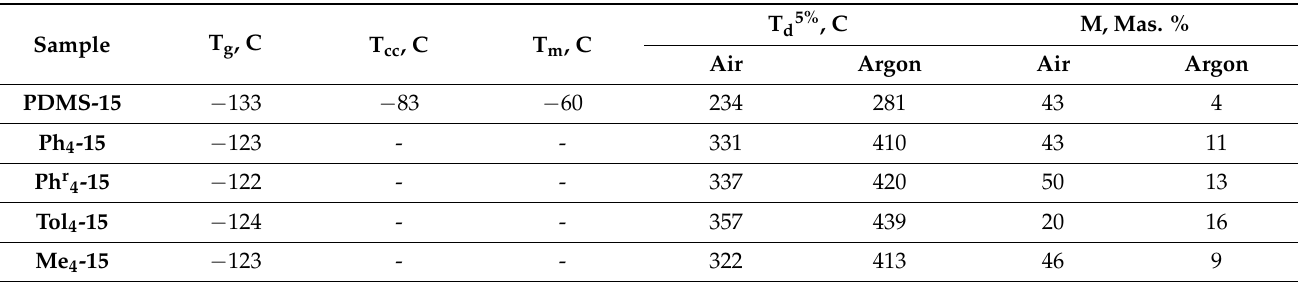
Table 2. Thermal characteristics of SSP obtained.